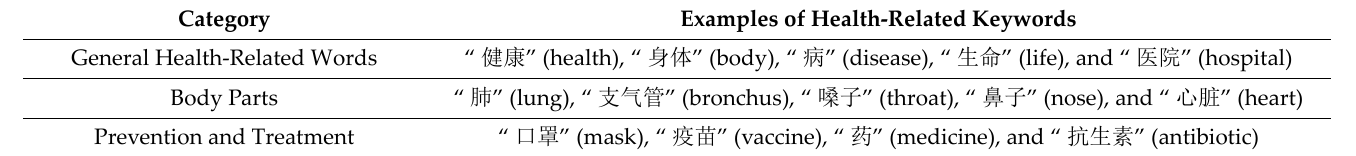
Table 1. Examples of health‑related keywords used for data